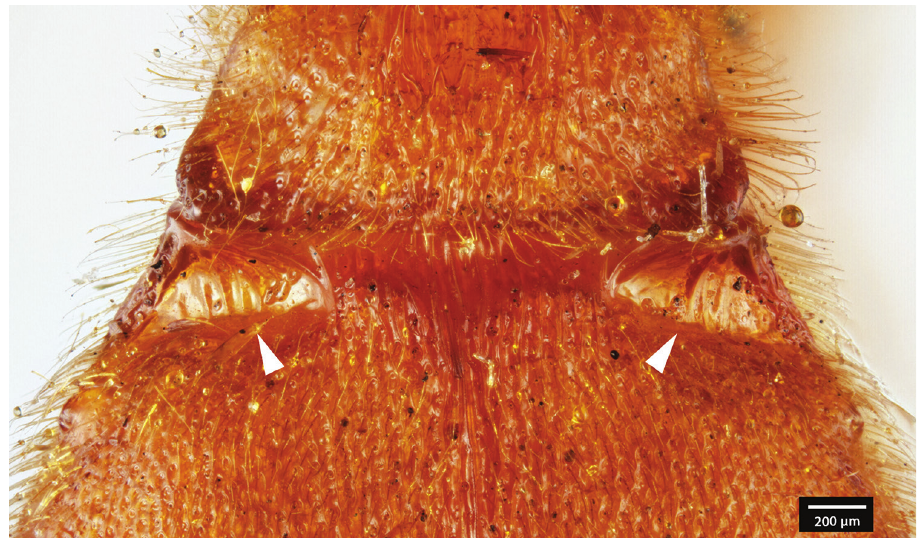
Figure 6. Brightfield images with arrows pointing to the patches of translucent cuticle in a Trogus sp. (Hymenoptera: Ichneumonidae) (identifier: PSUC_FEM 86178).